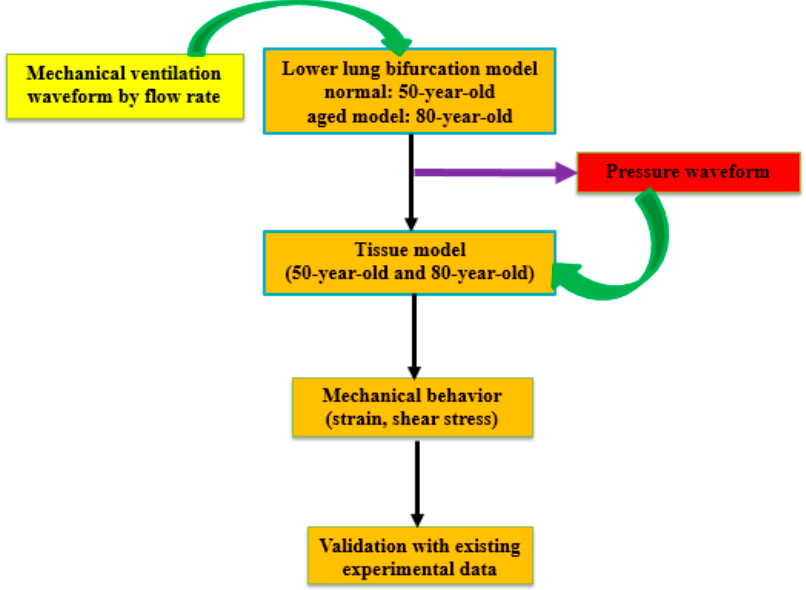
Figure 3. A schematic diagram of computational simulation of lung tissue with aging models